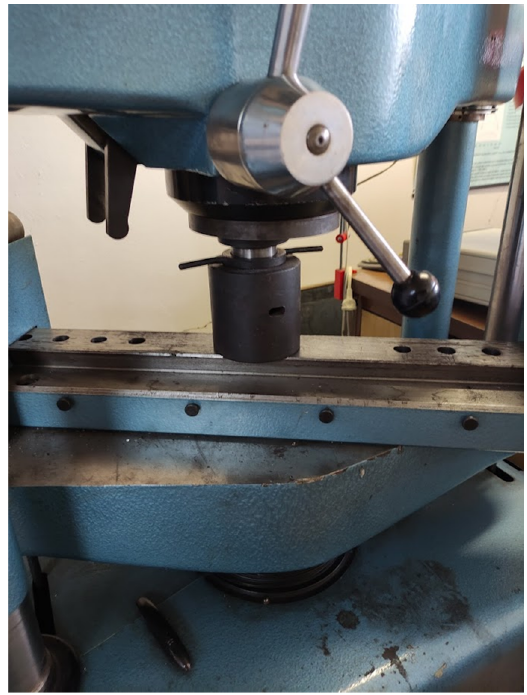
Figure 2. Hydraulic press used for compressive test.